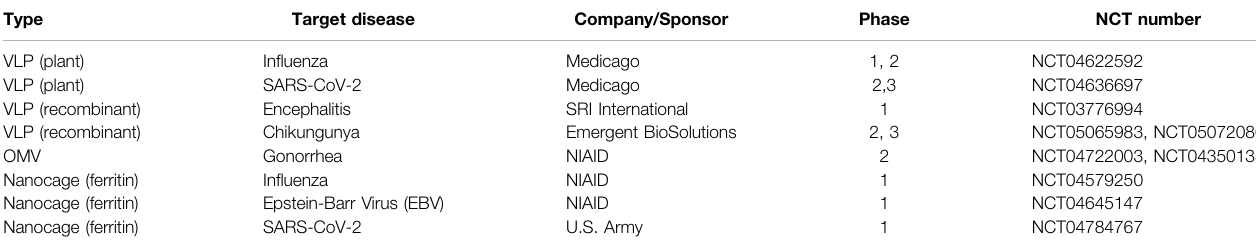
TABLE 2 | Biologically-derived nanoparticle vaccines recruiting or in active clinical trials in the United States.